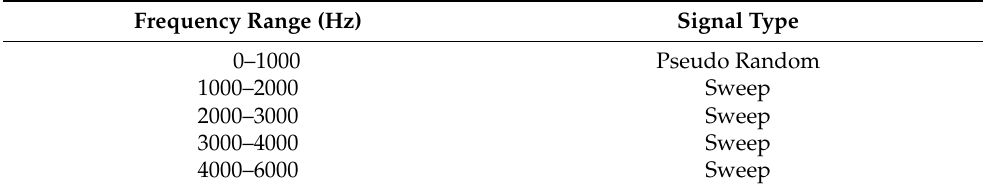
Table 3. Overview of frequency boundaries and signal type for separately excited and investigated frequency